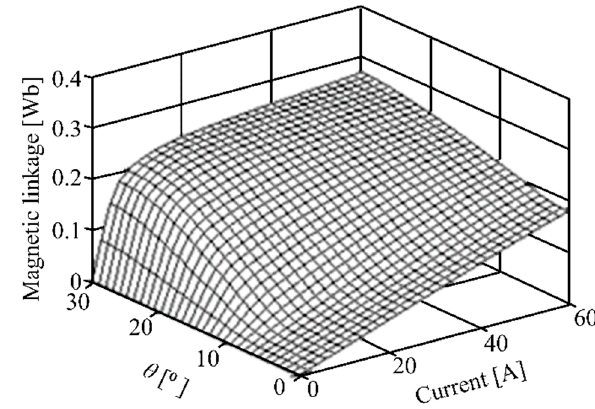
Figure 11. Magnetization map.